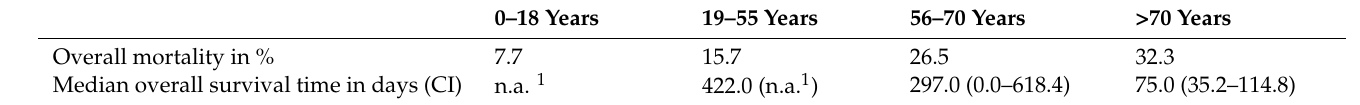
Figure 2. Population structure as analyzed by spa typing and BURP clustering. Clonally related spa types are grouped together in spa clonal complexes ( spa -CCs). Eight spa -CCs comprising 119 isolates were identified. The founder of each complex, i.e., the spa type of clonal origin, is calculated by the BURP algorithm as the sum of evolutionary steps between spa types which is condensed into founder scores [20]. The spa type with the highest founder score is defined as the founder and colored in blue. Should two spa types reach the same score, both will be colored in blue. Yellow color indicates the subfounders, identified by the second highest founder score within one complex. The lines connect the founder to the descendant spa types of one spa -CC, whereby black lines represent a direct relation (one evolutionary step) and lighter shades represent a more distant relation (up to four steps). The size of each circle symbolizes the number of isolates in this study that belong to the respective spa type. The size of blank space between different spa -CCs was chosen arbitrarily and provides no information about clonal distance between them. 12 spa types, comprising 18 isolates, could be grouped into clusters but not complexes as no founder was identified. These are shown at the bottom of this figure. 29 spa types were defined as singletons without clonal relation to other spa types in this study, these are not depicted in this figure. 10 isolates were excluded from the analysis by default settings as their spa sequence was shorter than five repeats. For details on numbers of isolates per spa type and spa -CC, see Table 4 and Supplementary Table S2. Table 5. Impact of patient age on overall